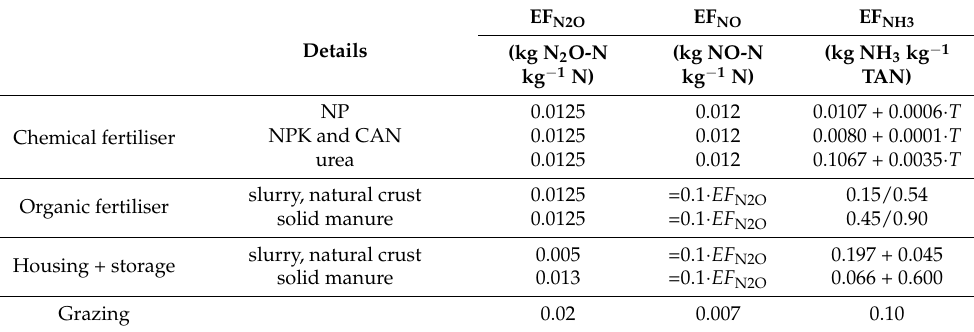
Table 2. Emission factors (EFs) used for calculations